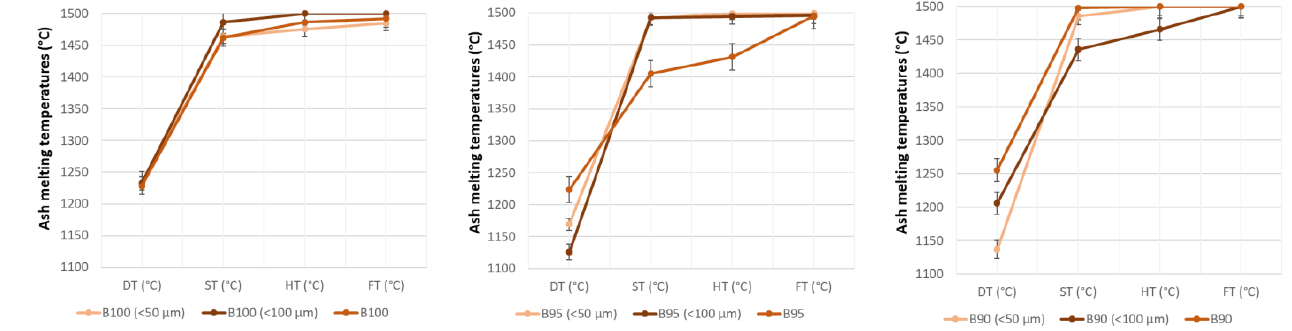
Figure 3. Differences in melting temperatures for beech samples prepared at 550 °C.